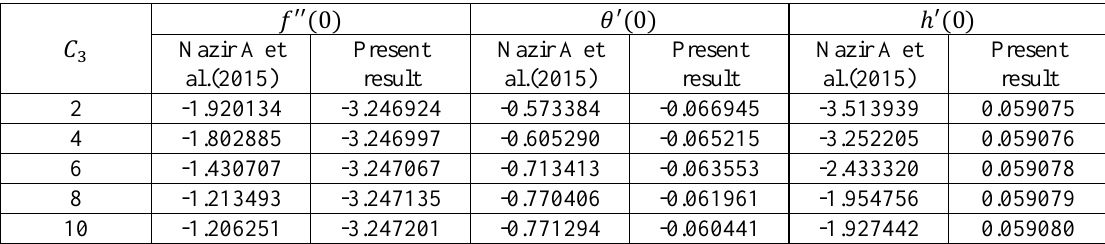
Table 7. Comparison of missing values with original paper for different 𝐶